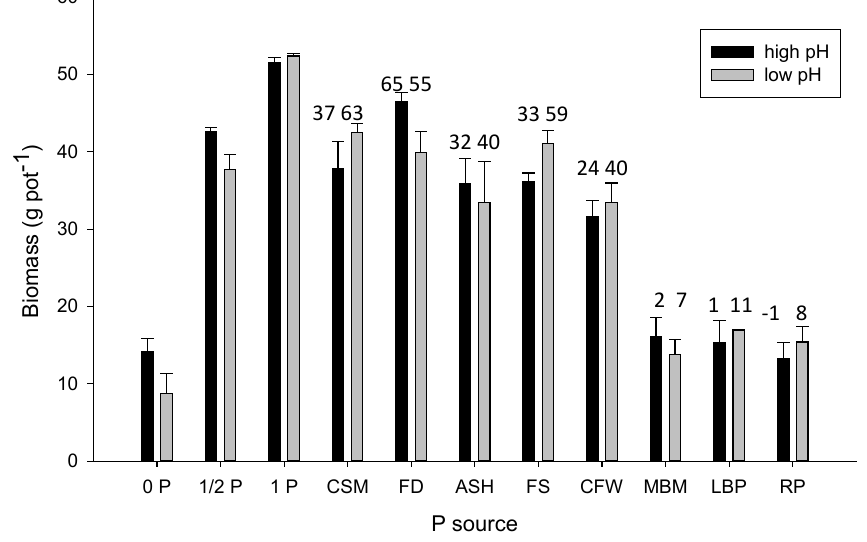
Fig. 1. Biomass production in aboveground biomass as a function of P source. Error bars are standard error (n=3). From left: no P, half optimal P, optimal P, followed by the various waste materials where total P addition in each was equal to optimal P. Mineral fertilizer equivalent for each P source are shown on top of each bar.